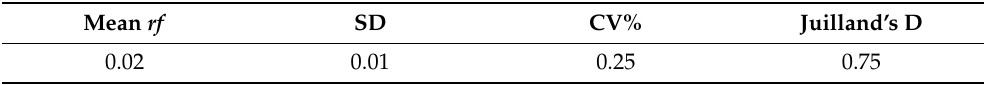
Table 8. Dispersion analysis of the central word among the sections for the year 2021.